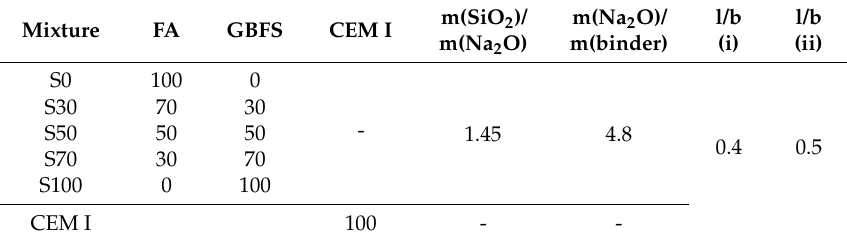
Table 2. Mixture design with respect to 100 g of